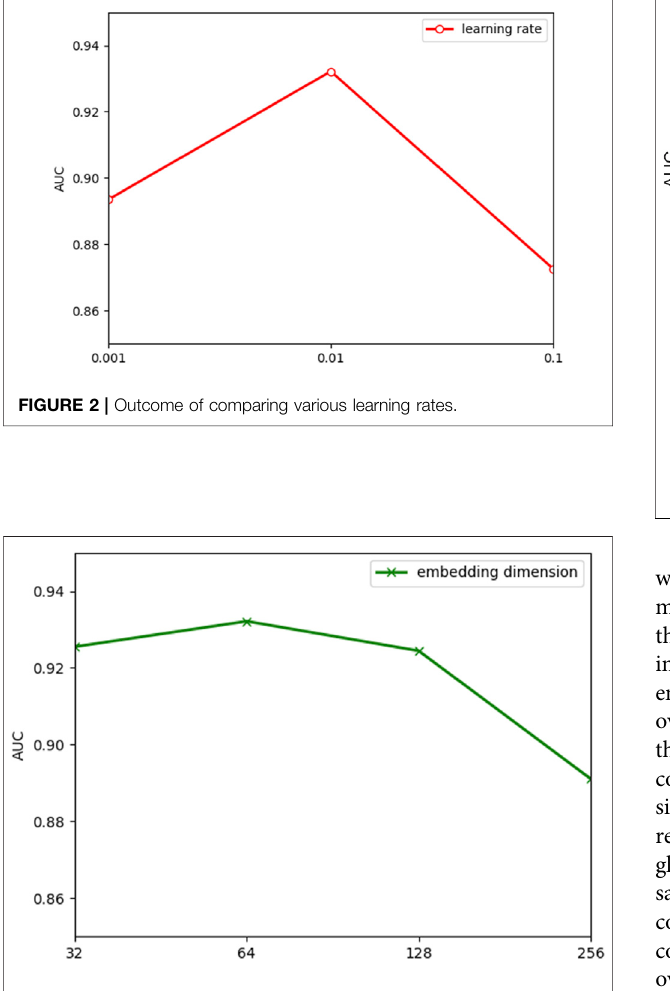
FIGURE 3 | Outcome of comparing various embedding dimensions.